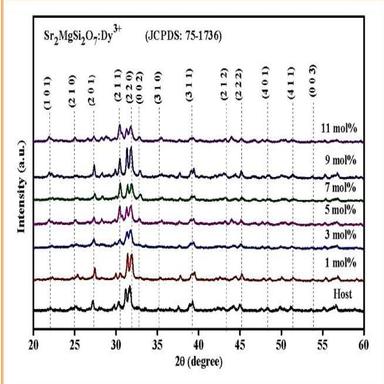
XRD pattern for Sr2MgSi2O7:Dy3þ (1–11 mol %) NPs.